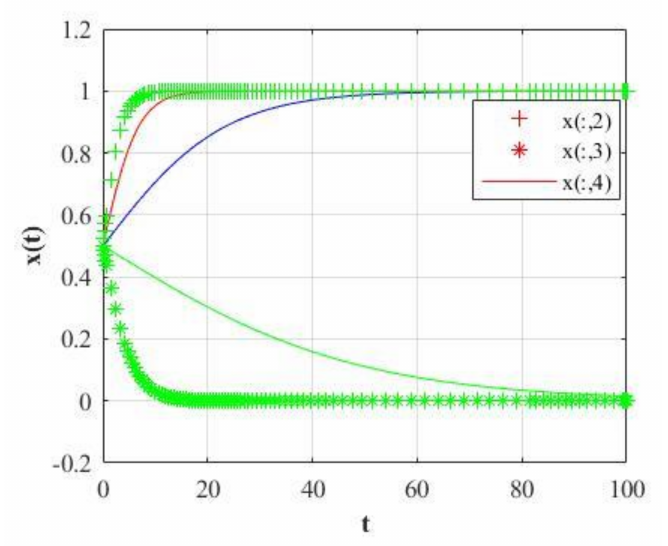
Figure 20. Change the parameter δ 4 , λ 2 = (0.8,0.2) red curve, (0.5,0.5) blue curve, (0.2,0.8) green curve to take the value of the three-way strategy evolution